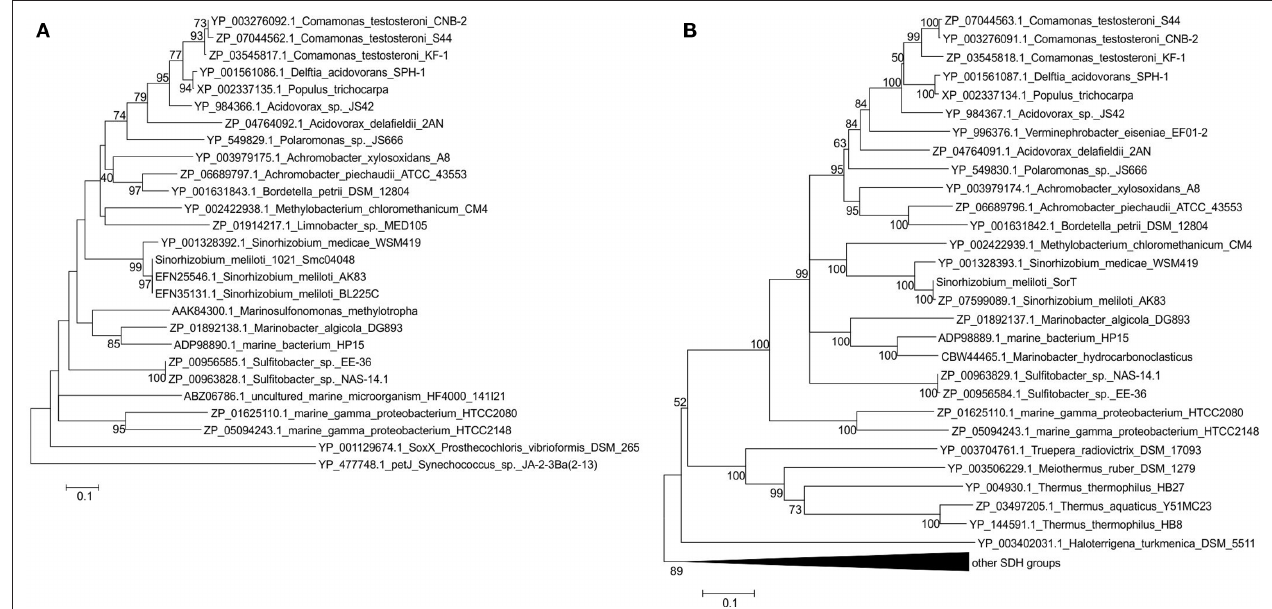
Figure 7 | Phylogenetic analysis of Smc04048 and SorT related protein sequences available in the database. (A) Neighbor-joining tree or Smc04048 related protein sequences (B) neighbor-joining tree of SorT (Smc04049). Bootstrapping used 500 samples, for clarity bootstrap values below 40 are not shown. Minimum Evolution and Maximum Parsimony algorithms were also used and generated trees with the same topology and very similar bootstrap